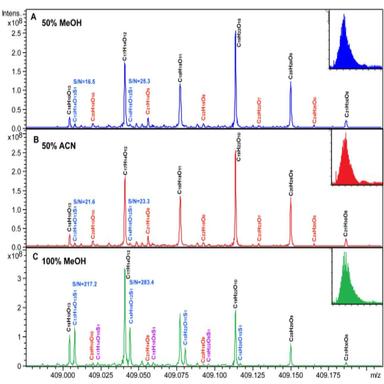
The scale-expanded FTICR mass spectra of NOM at nominal m/z 409 with different spray solvents, (A) 50% MeOH aqueous solution, (B) 50% ACN aqueous solution, (C) 100% MeOH. Inserted figures on top right are the full scale FTICR mass spectra with m/z ranged from 185 to 1000. The empirical formulas for each peak are denoted as CnHmOqSx.